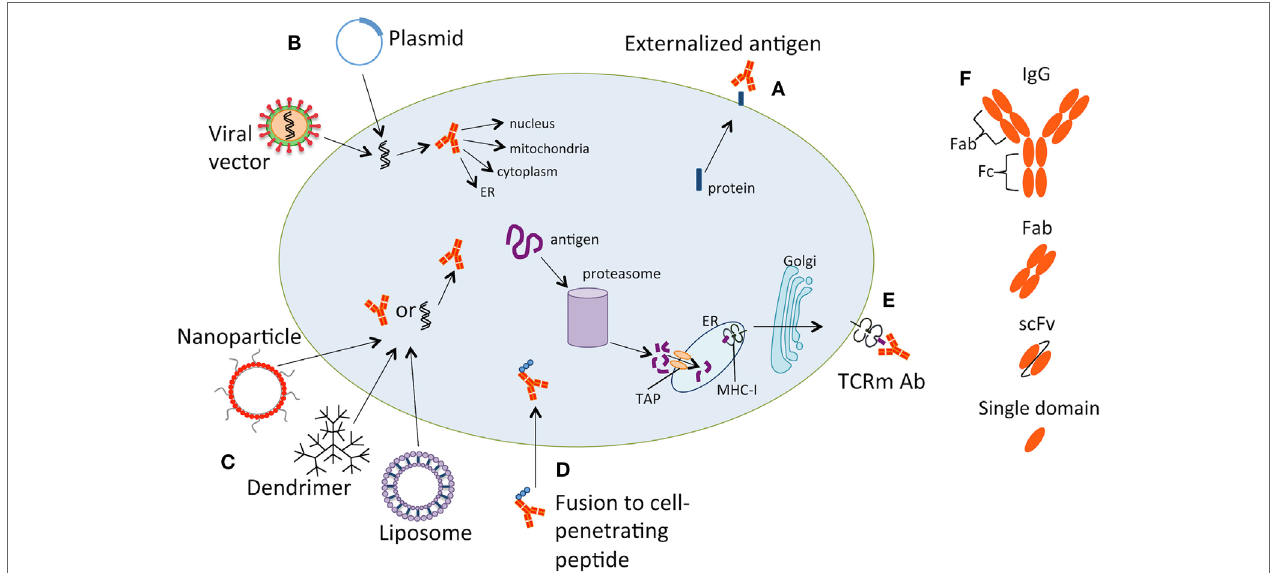
FiGURe 1 | Strategies for targeting intracellular tumor antigens with antibody therapy. Some of the methods for targeting intracellular tumor antigens are illustrated. (A) Intracellular antigens can be externalized on the cell surface or secreted, allowing targeting by antibodies. (B) Plasmids or viral vectors can be used to deliver antibody-encoding genes into the cell. Once internalized, the DNA is transcribed into the targeting antibody, which can be designed to translocate to the nucleus, mitochondria, endoplasmic reticulum (ER), or cytoplasm. (C) Nanoparticles, dendrimers, or liposomes can be used to deliver an antibody or an expression vector encoding the intracellular antibody into the target cell. (D) Antibodies can be fused to cell-penetrating peptides, which allow internalization of the antibody. (E) T-cell receptor mimic (TCRm) antibodies can be used to target peptides bound to major histocompatibility complex class I (MHC-I) molecules on the cell surface. The peptides are derived from intracellular proteins, which have been degraded by the proteasome into short peptides. Peptides are loaded onto MHC-I molecules in the ER, transported through the Golgi apparatus, and finally presented on the cell surface. (F) The antibody depicted on the diagram could represent a full-length IgG, a Fab fragment, scFv or a single domain